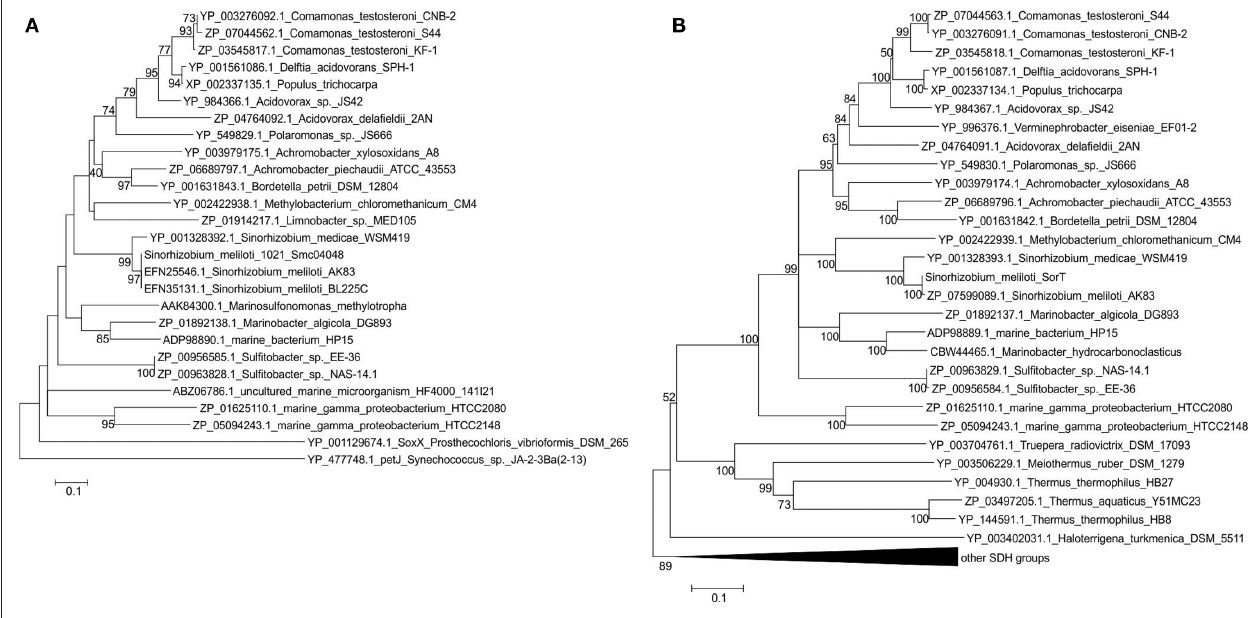
values for both sequences setc. Sequence accession numbers are shown in the figure. The sequences from the two marine gamma Proteobacteria are fusions between a smc04048 and a sorT genes, the cytochromes from Sulfitobacter species are diheme cytochromes. The pseudogene Veis_1600 that encodes an Smc04048 related protein from Verminephrobacter eiseniae was not included in